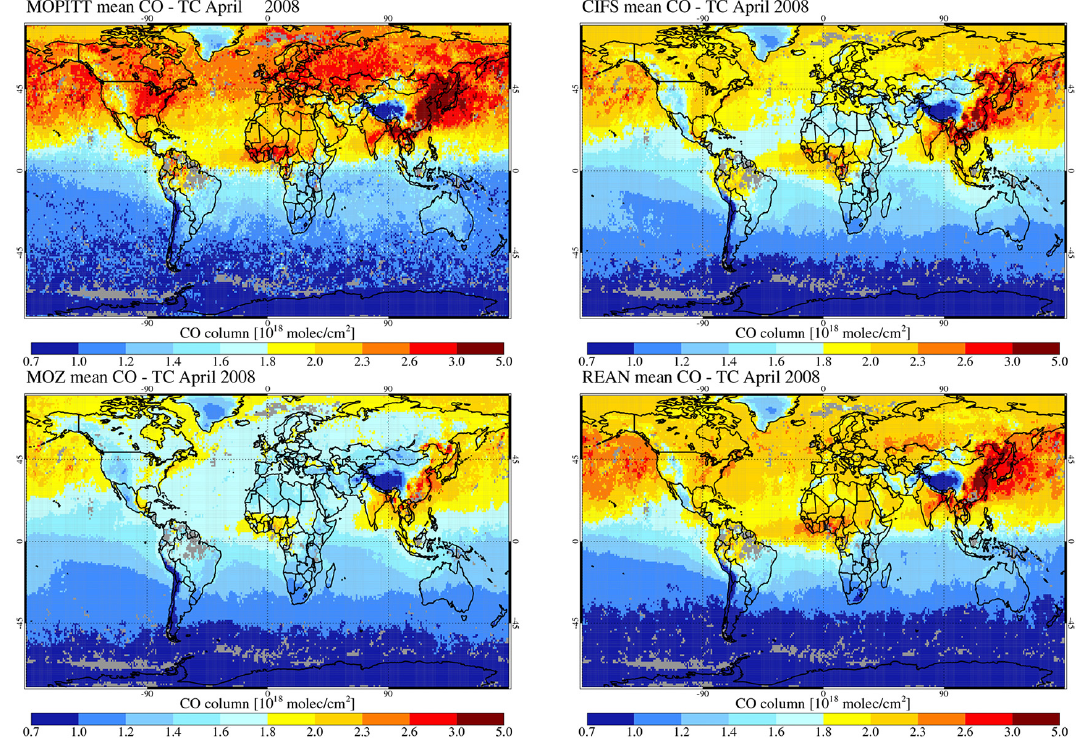
Figure 6. CO total column retrieval (MOPITT V6) for April 2008 (top left) and simulated by C-IFS (top right), MOZ (bottom left) and REAN (bottom right); AK are